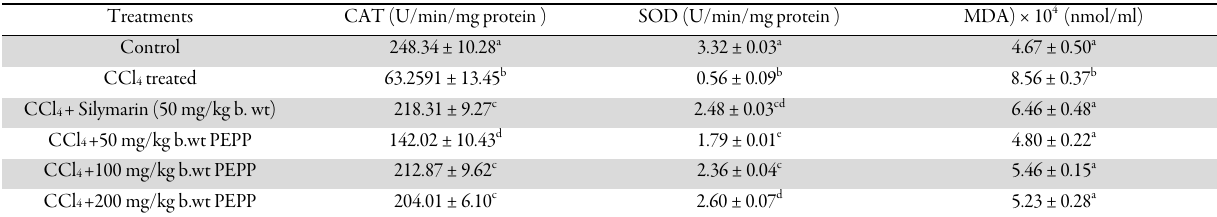
Values are expressed as means of 5 replicates ± SEM. Values with the same superscript along the column are not significantly different (p <